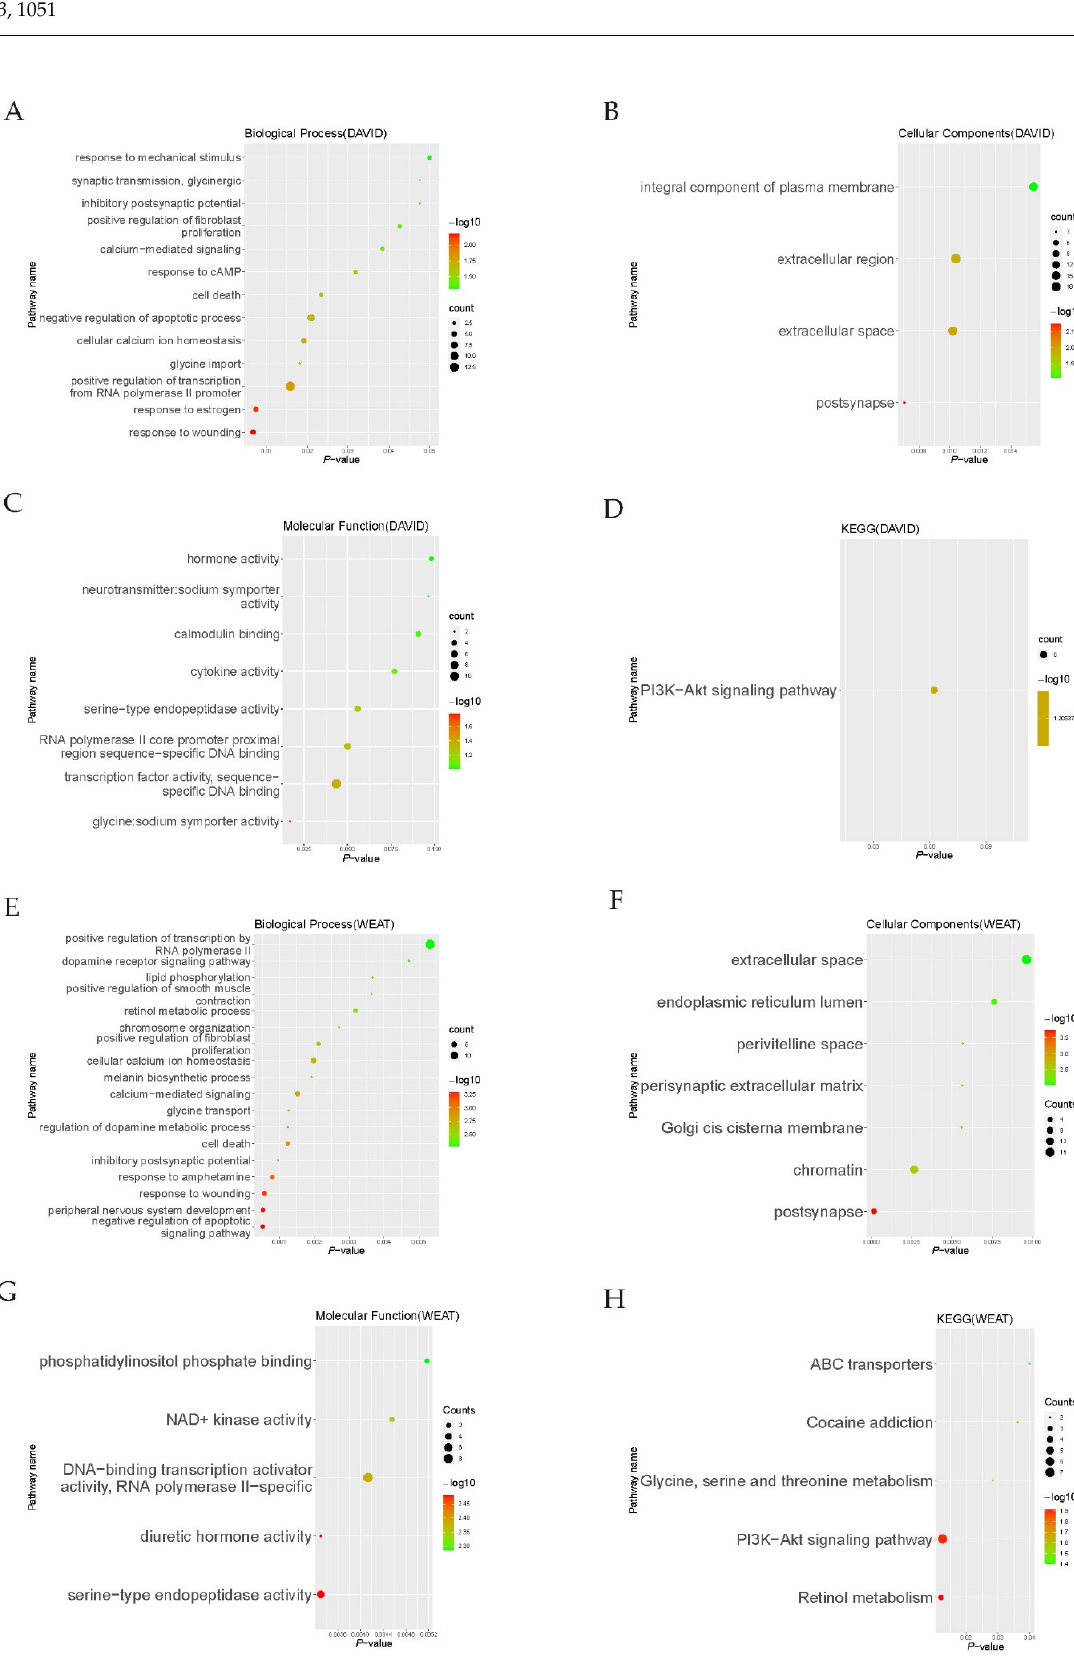
Figure 3. GO and KEGG analyses of downregulated genes screened by the strict cutoff. ( A – C ) DAVID GO analyses of downregulated genes. ( D ) DAVID KEGG analysis of downregulated genes. ( E – G ) WEAT GO analyses of downregulated genes. ( H ) WEAT KEGG analysis of downregulated genes. BP, biological process; CC, cellular component; MF, molecular